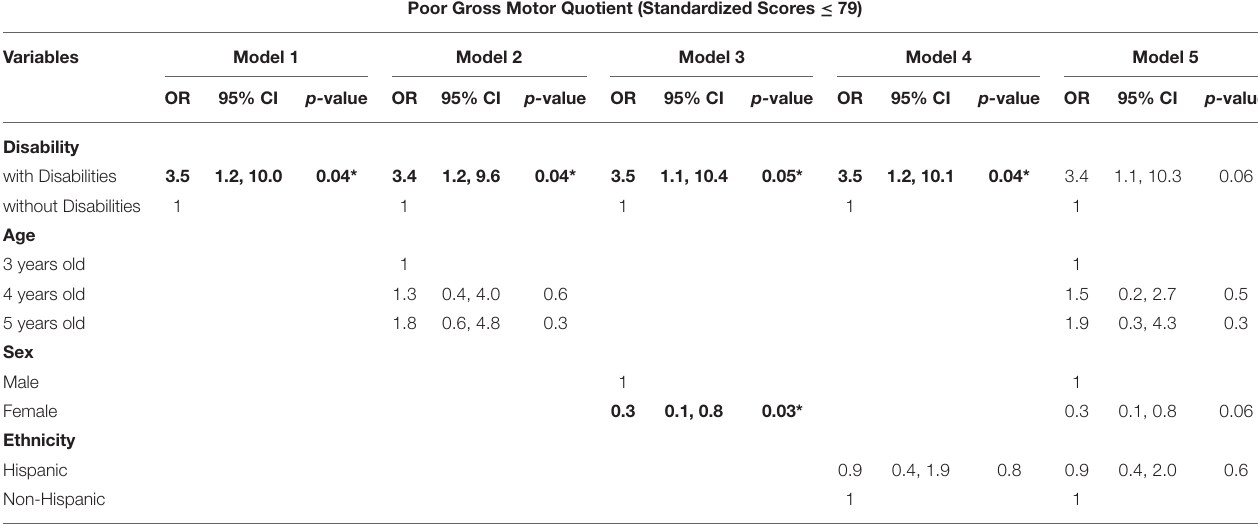
TABLE 3 | Logistic regression of Gross Motor Quotient between children with and without disabilities.